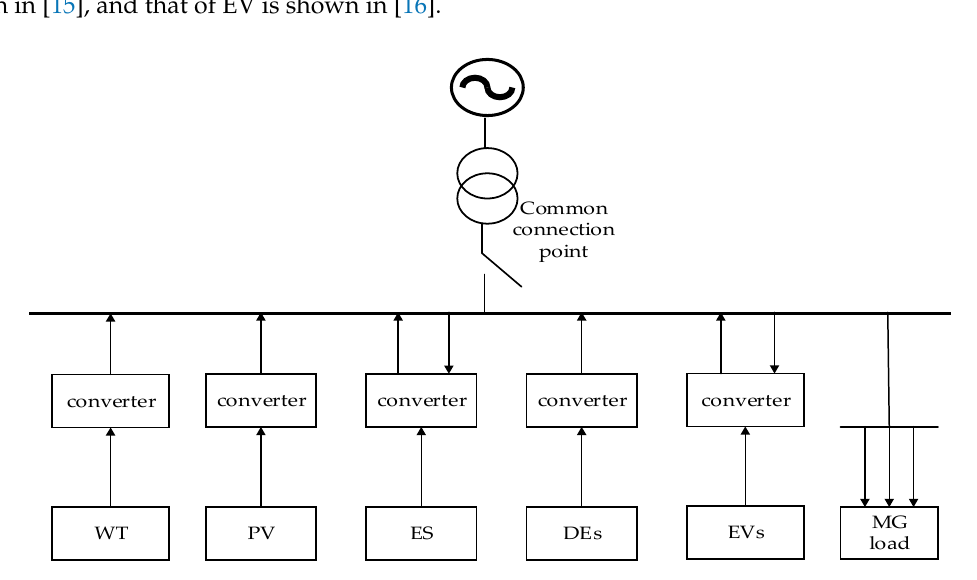
Figure 1. Structure diagram of the Microgrid (MG) system.